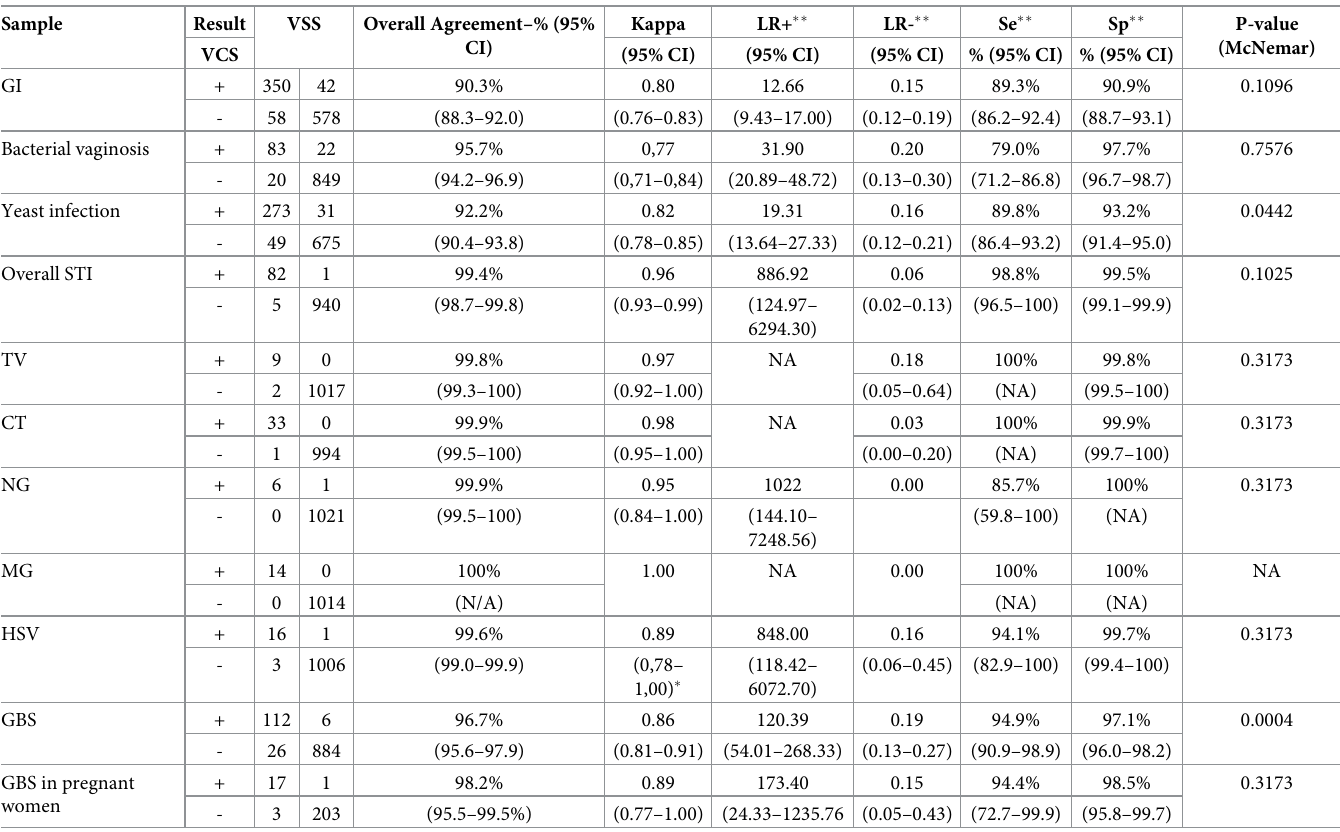
Table 3. Agreement between VSS and VCS for the detection of GI